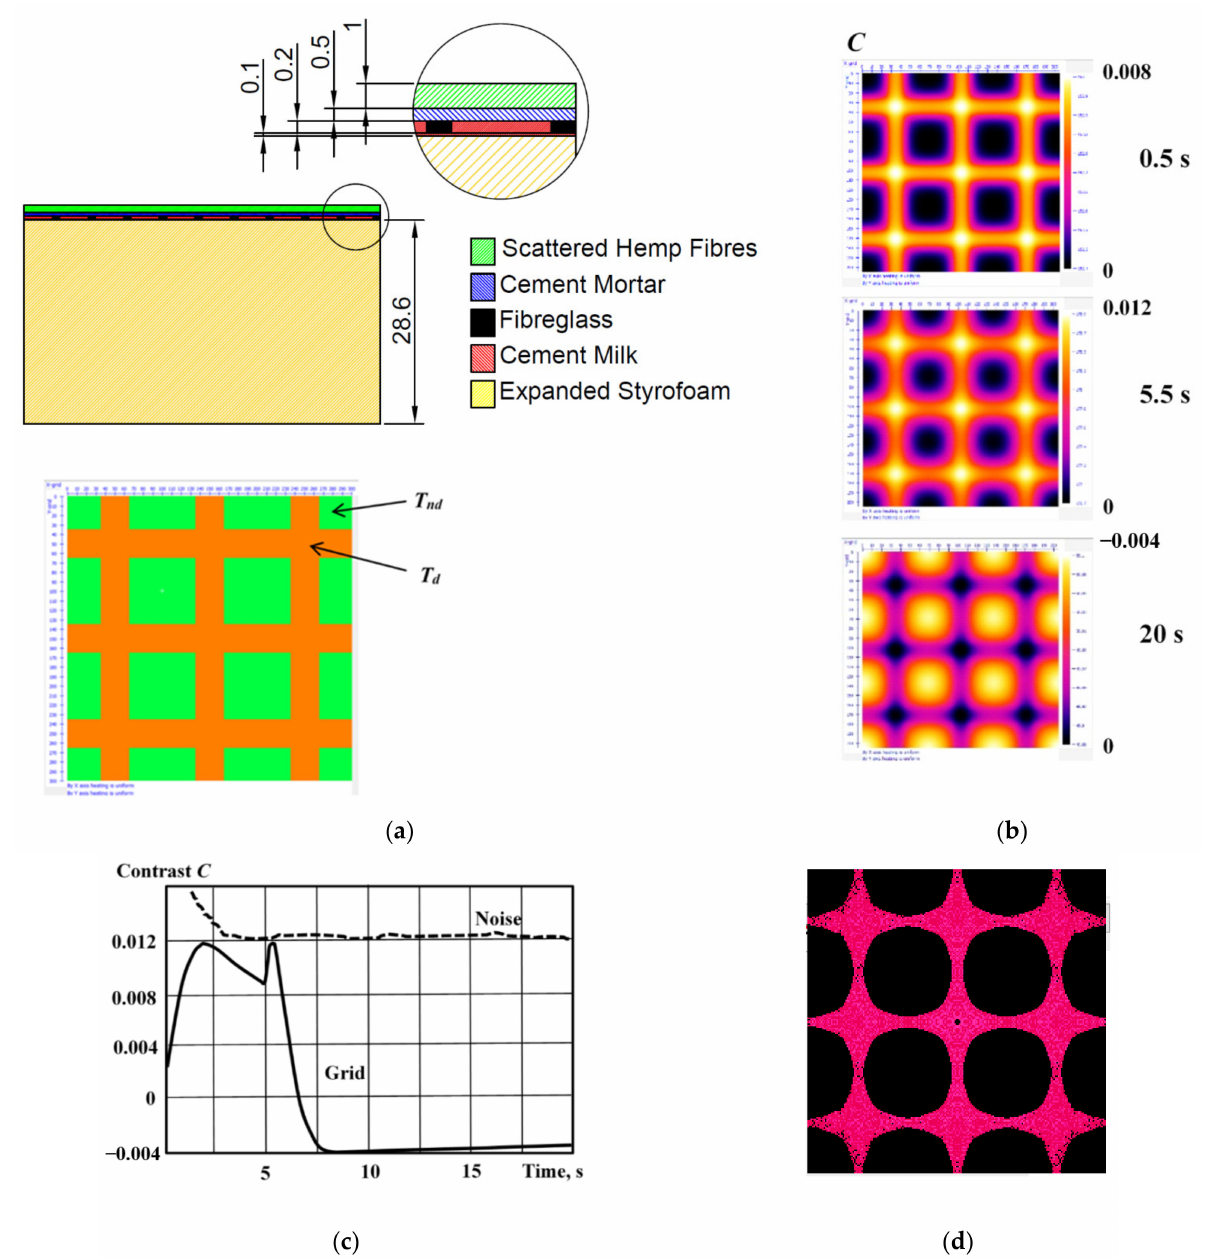
Figure 17. Modelling active TNDT of the specimen shown in Figure 1a,b (material thermal properties: Scattered hemp fibres—K = 0.038 W m − 1 K − 1 , C = 1700 J kg − 1 K − 1 , ρ = 25 kgm − 3 ; Cement mortar—K = 1.73 W m − 1 K − 1 , C = 210 J kg − 1 K − 1 , ρ = 900 kgm − 3 ; Fiberglass—K = 0.035 W m − 1 K − 1 , C=1030 J kg − 1 K − 1 , ρ = 21 kgm − 3 ; Cement milk—K = 1.4 W m − 1 K − 1 , C=0.87 J kg − 1 K − 1 , ρ = 1540 kgm − 3 ; Expanded Styrofoam—K = 0.03 W m − 1 K − 1 , C = 1450 J kg − 1 K − 1 , ρ = 30 kgm − 3 ). ( a ) 3D numerical model (ThermoCalc-3D software); ( b ) images of temperature contrast at three different times; ( c ) contrast evolution; ( d ) thermal tomogram of the grid